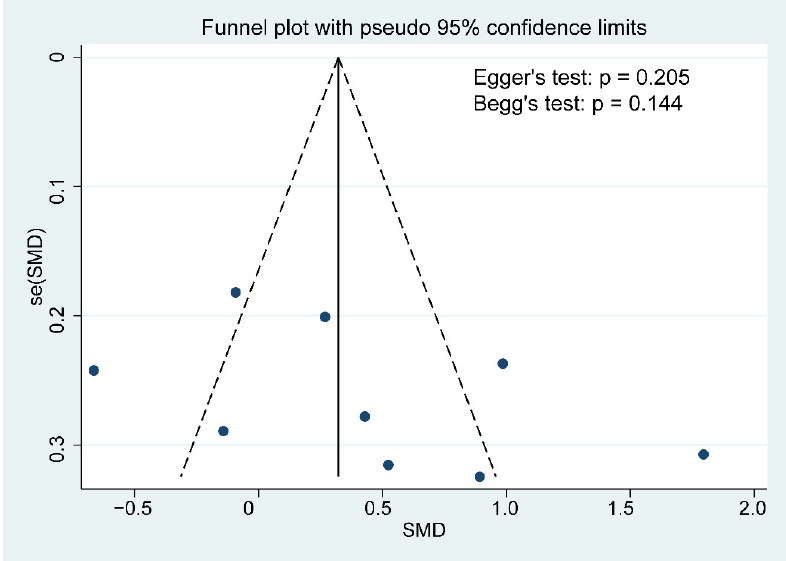
Figure 5. Funnel plot demonstrating publication bias in the meta-analyses. Each circle represents one study; and the vertical line indicates the weighted mean effect. The funnel plot asymmetry was assessed with Begg and Egger tests. A p value < 0·1 was defined as significant publication bias.